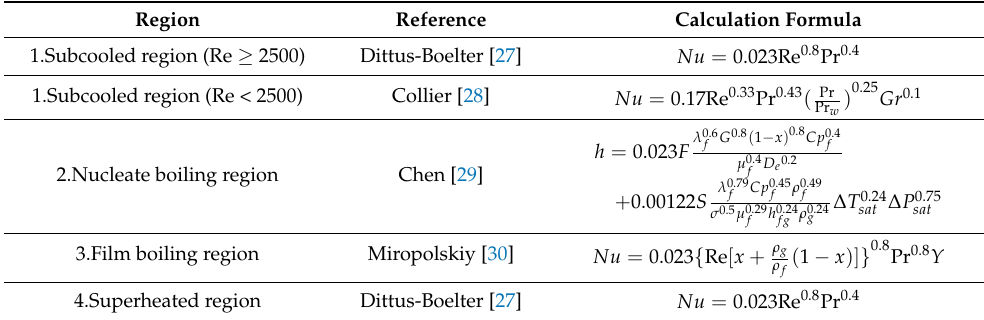
Table 1. Heat transfer correlations in different